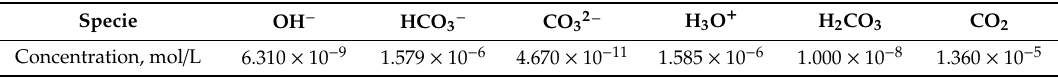
Table 1. Basic species and their concentrations in the deionized (DI)